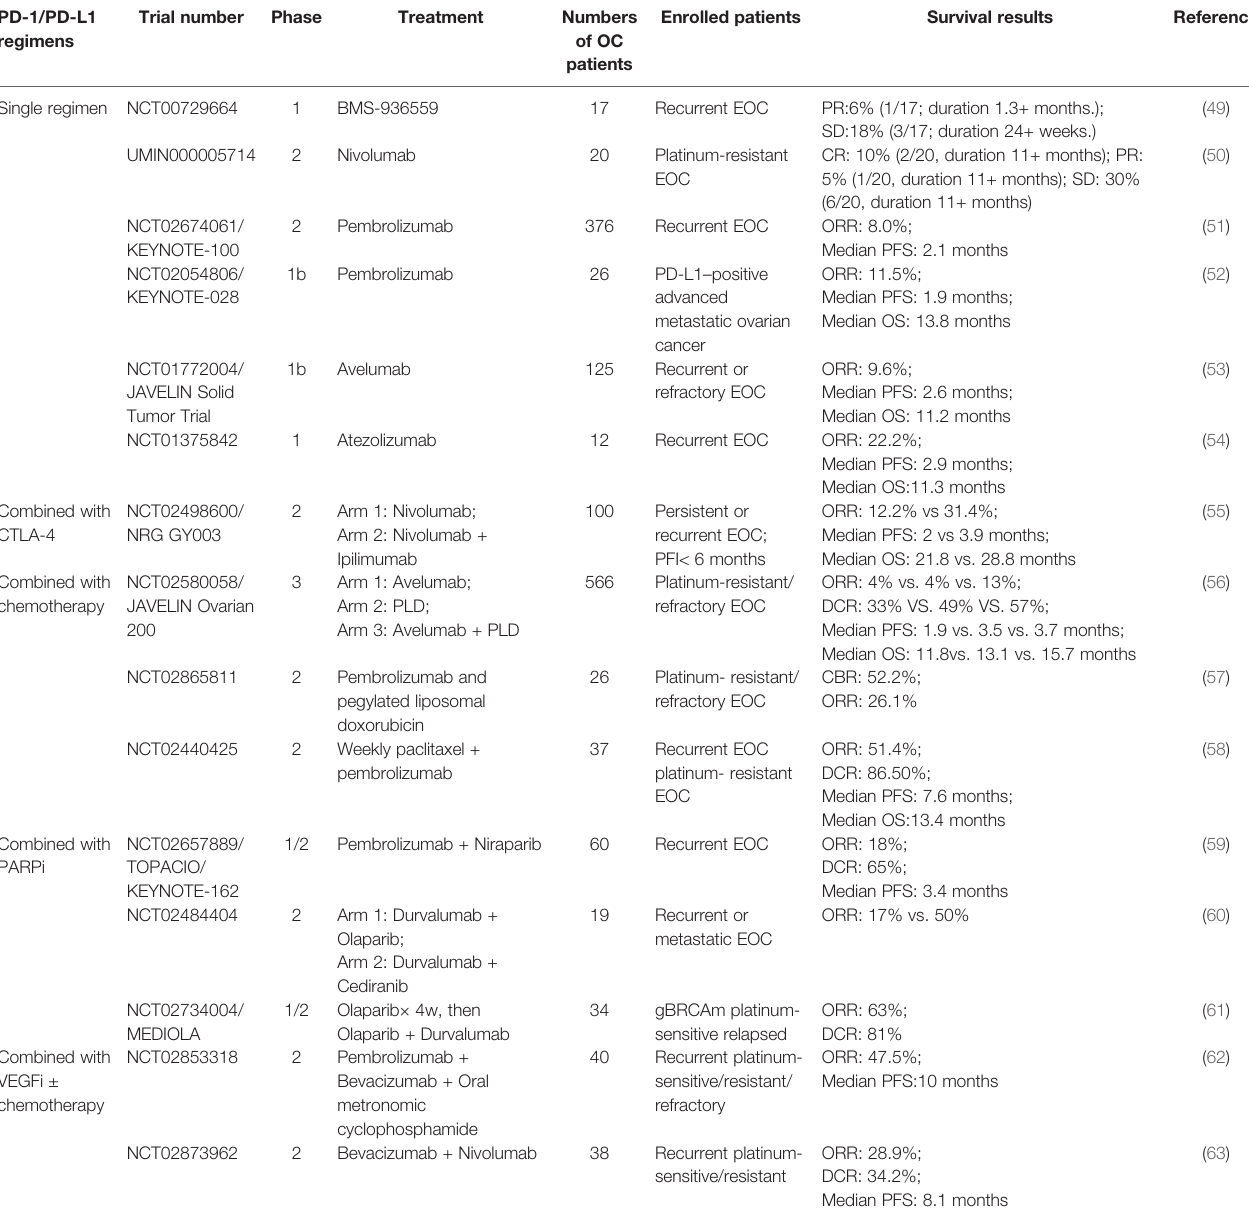
Enrolled patients Survival